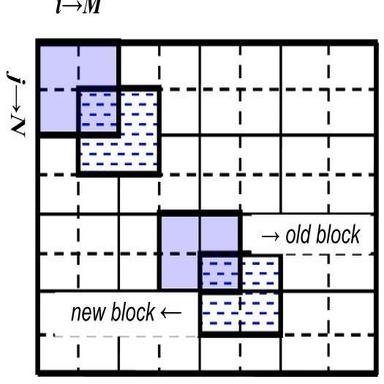
Schematic map of the shifting rules of blocks in an image plane.